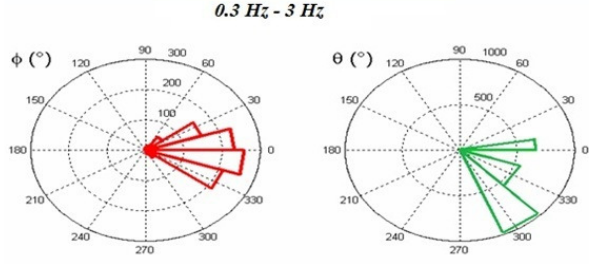
Fig. 8. The arrival direction of the anomalous Fig. 8 Arrival direction of the anomalous signal .